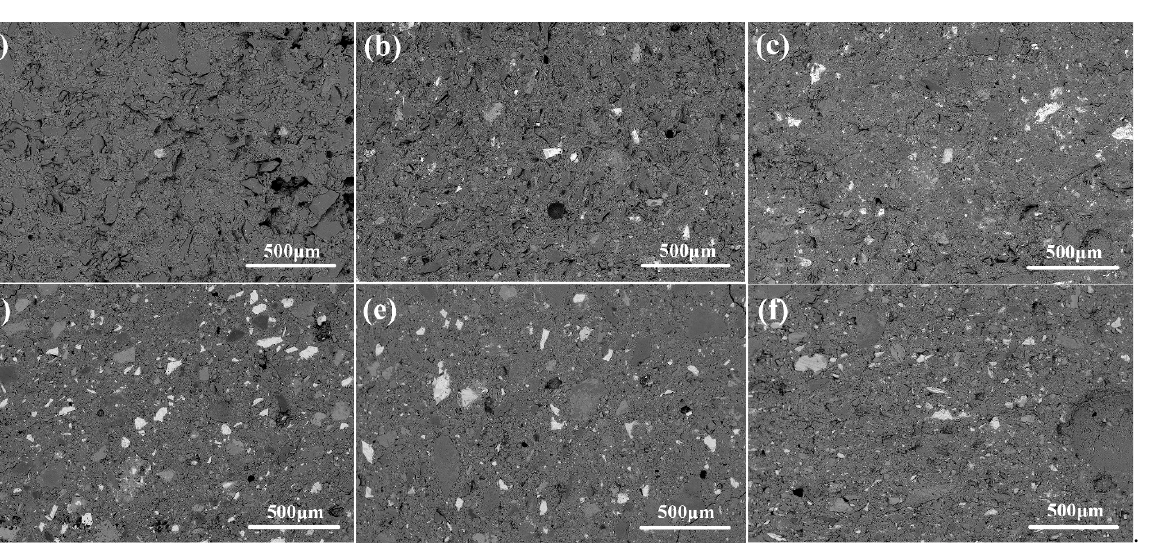
Figure 4. Element mapping images of 28d MASMs with different SRCT composites: ( a ) M5S; ( b ) M10S; ( c ) M13S; ( d ) M15S; ( e ) M20S. Table 3. Migration rate of sulfur of the 28d MASM based on Figure 4. Group